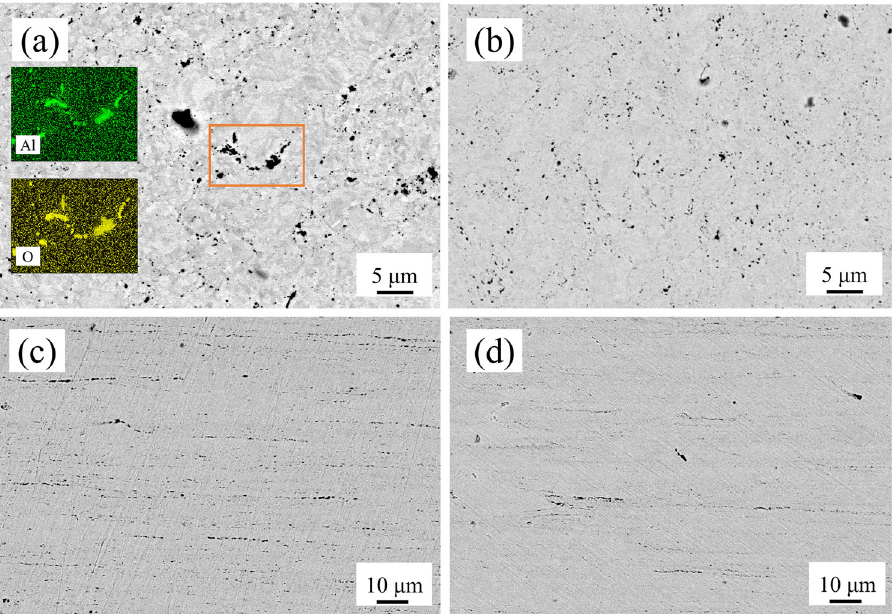
Figure 6: BSD morphology of as - extruded samples: ( a and b ) cross - section and ( c and d ) longitudinal section of ( a and c ) non - milled sample and ( b and d ) milled sample.